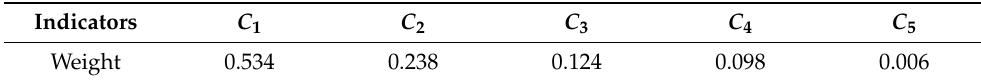
for the first-level i